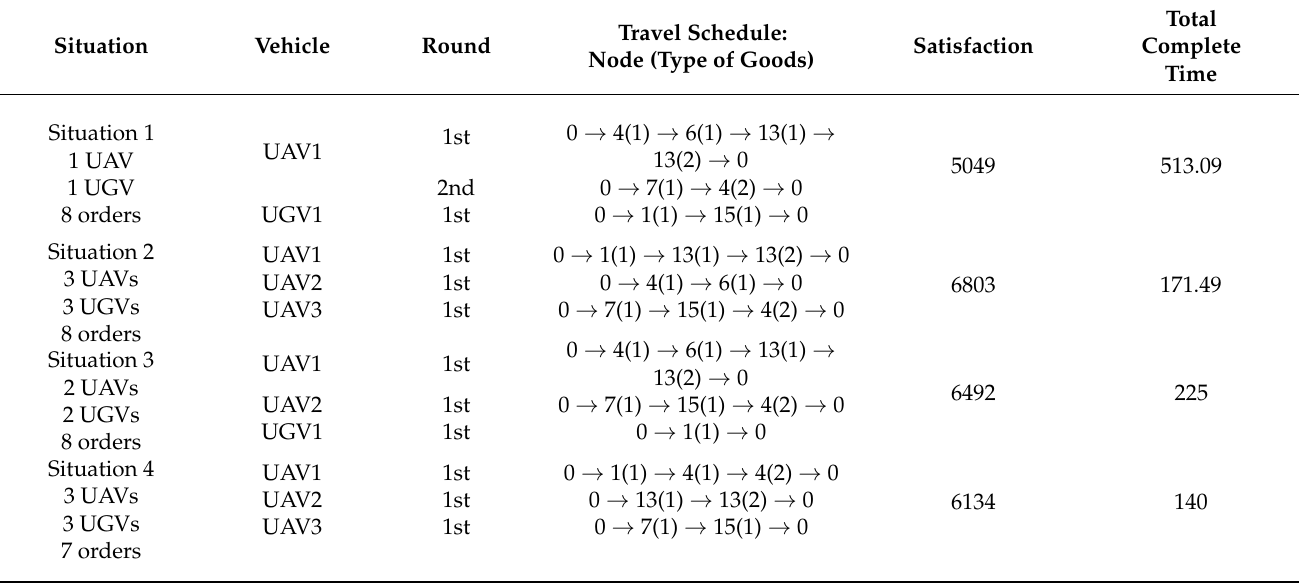
Table 3. The result of small size problem (Case